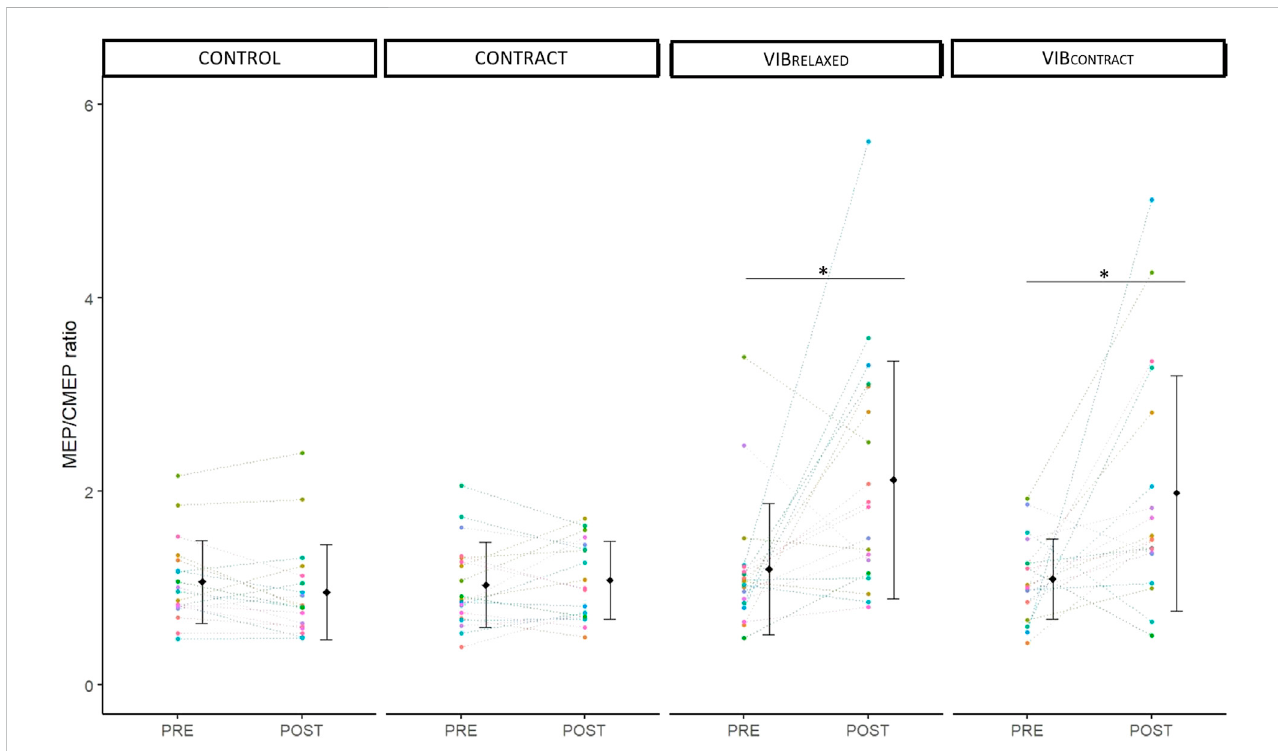
FIGURE 5 Mean and individual MEP/CMEP ratio. PRE and POST values are represented for each condition. Each dot represents the value of a participant. * represents signi fi cant differences between PRE and